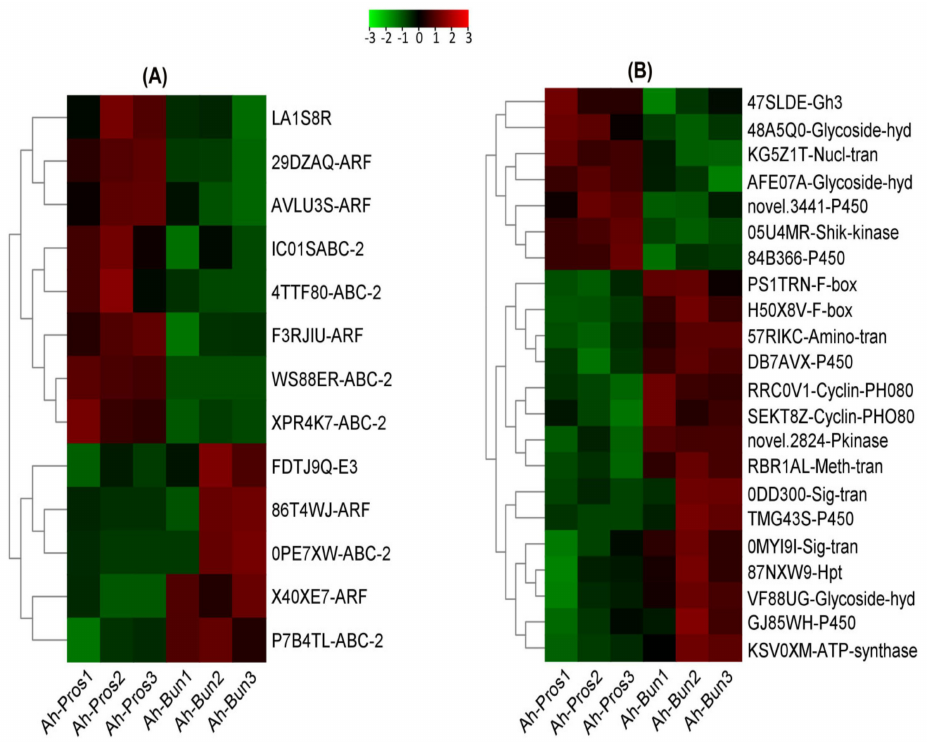
Figure 6. The differential expression pattern of genes involved in the lateral branch angle regulation of prostrate and bunch type peanut ( A ) The expression changes of gravitropism related genes between prostrate and bunch peanut ( B ) The expression changes of genes related to plant hormone and signaling pathways between prostrate and bunch peanut. Scale bar at the top is log2foldchange ratio varying from green (down) to red